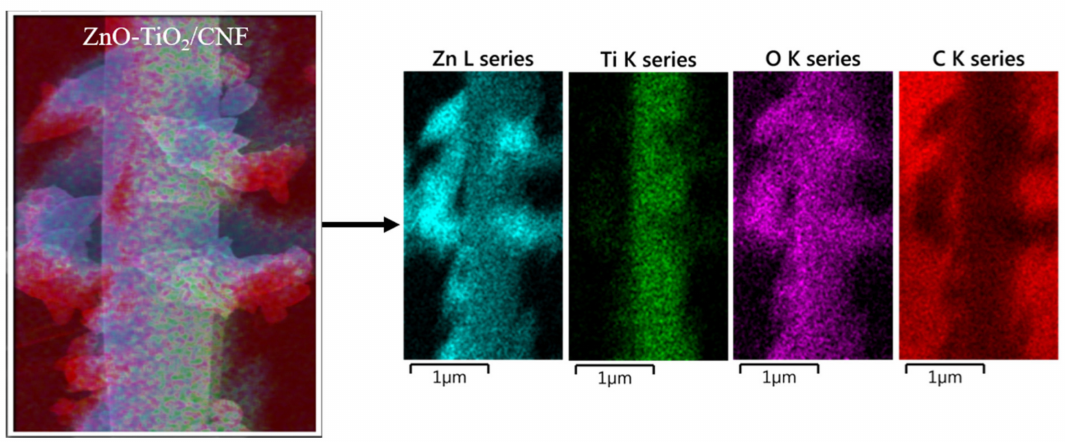
Figure 2. Elemental mapping of the as-prepared ZnO-TiO 2